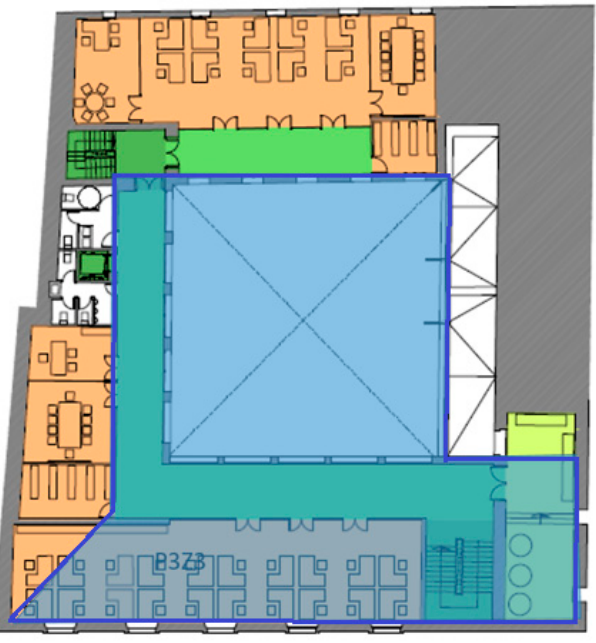
Figure 9. Plan view of the top floor of the building.